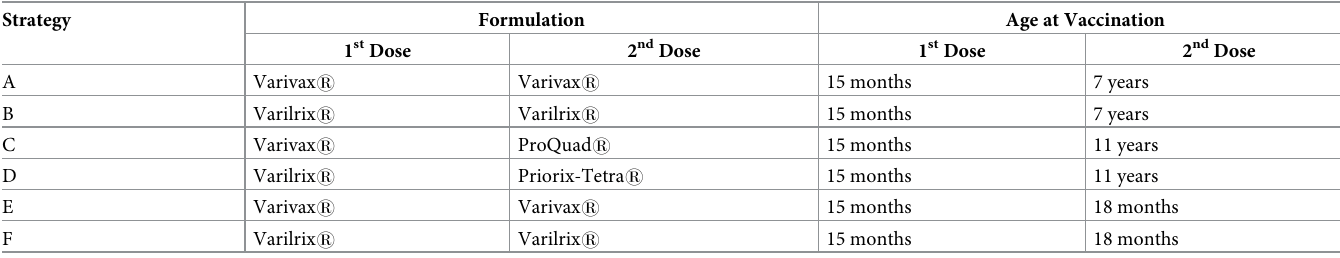
Table 1. Vaccination strategies A